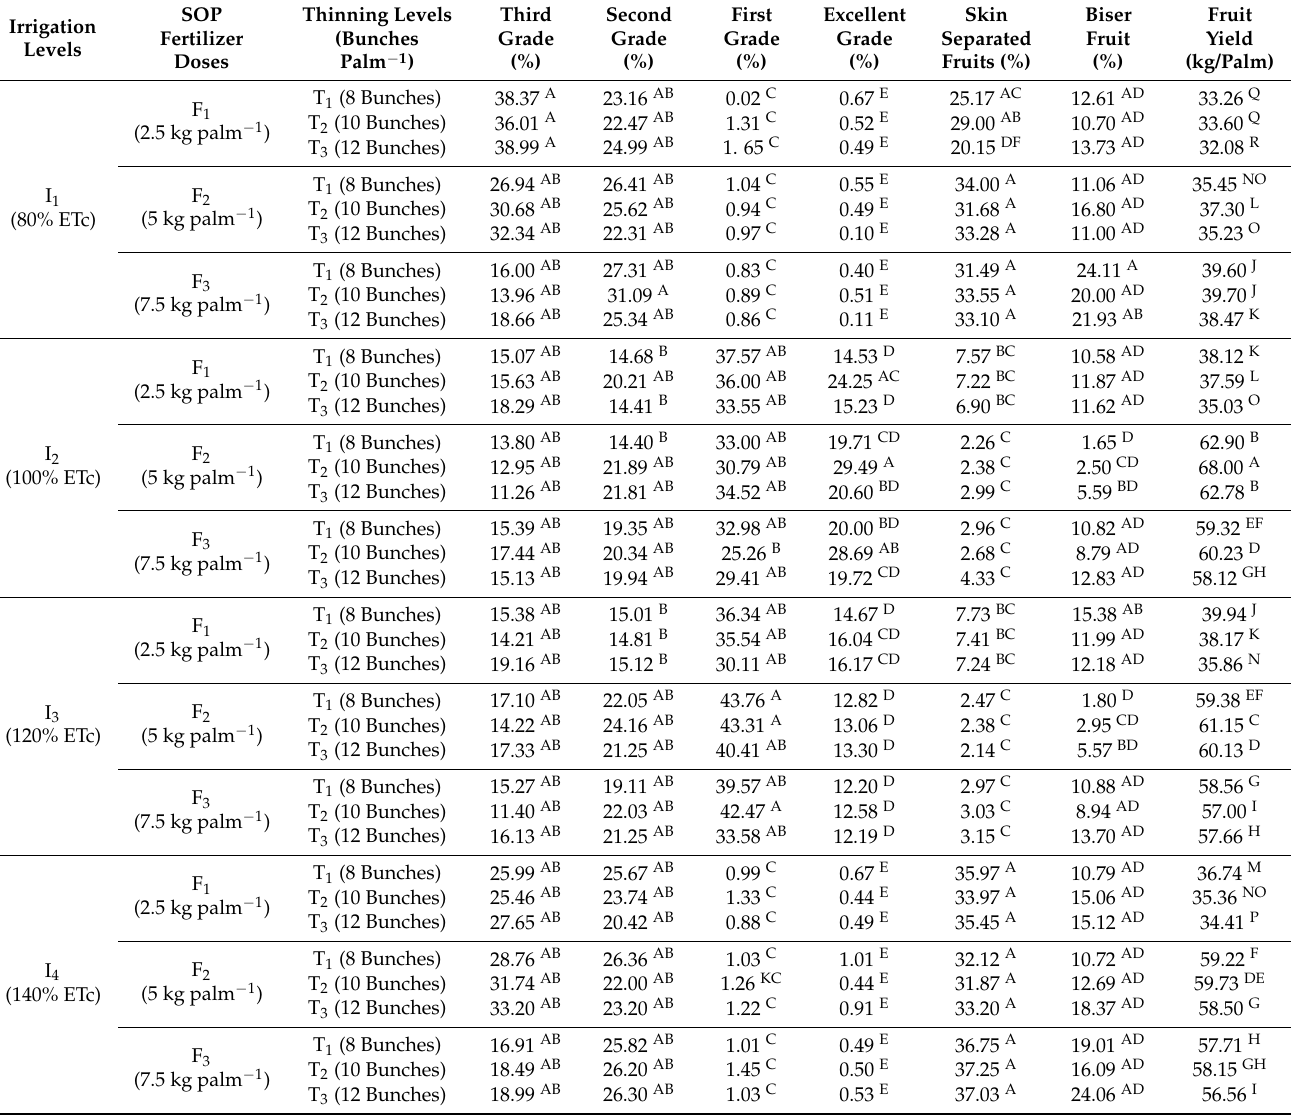
Table 6. Effects of irrigation levels, SOP fertilizer doses, and bunch thinning levels on fruit grading (third, second, first, and excellent), skin separated fruits, biser fruits, and total fruit yield of date palm cv. Sukary. Each mean data represents the averages from two seasons,